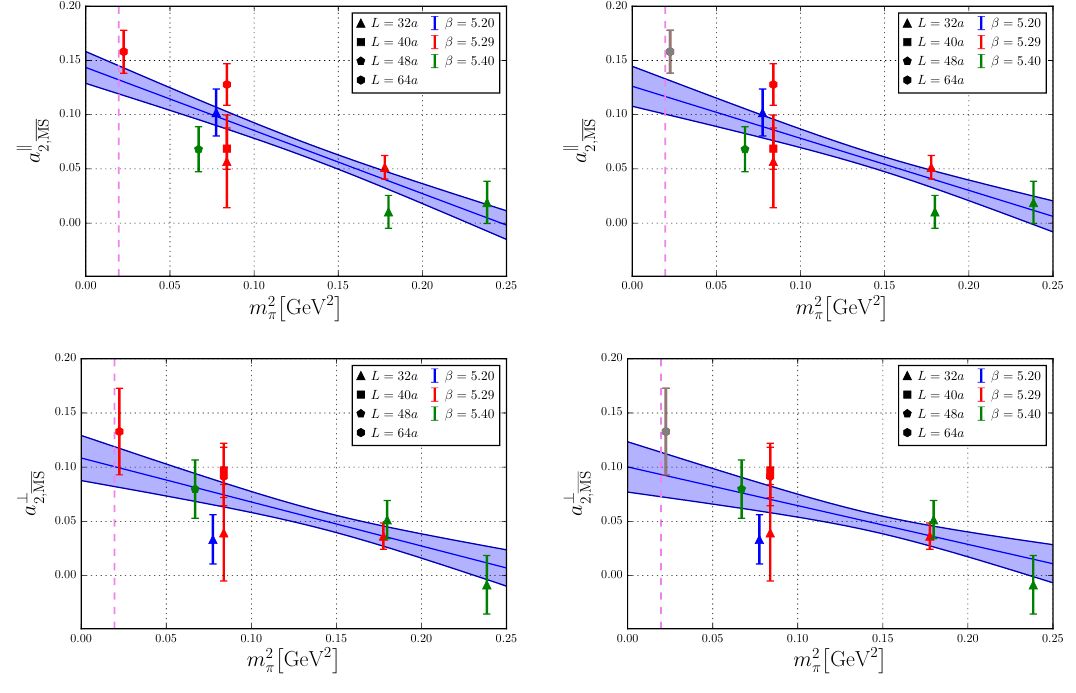
Figure 3 . Linear (cid:12)ts for the second Gegenbauer moments a transversely polarized leading twist distribution amplitudes, including (left) and excluding (right) the data point at m (cid:25) = 150 MeV. The violet dashed line indicates the position of the physical pion mass. The band indicates the one sigma statistical